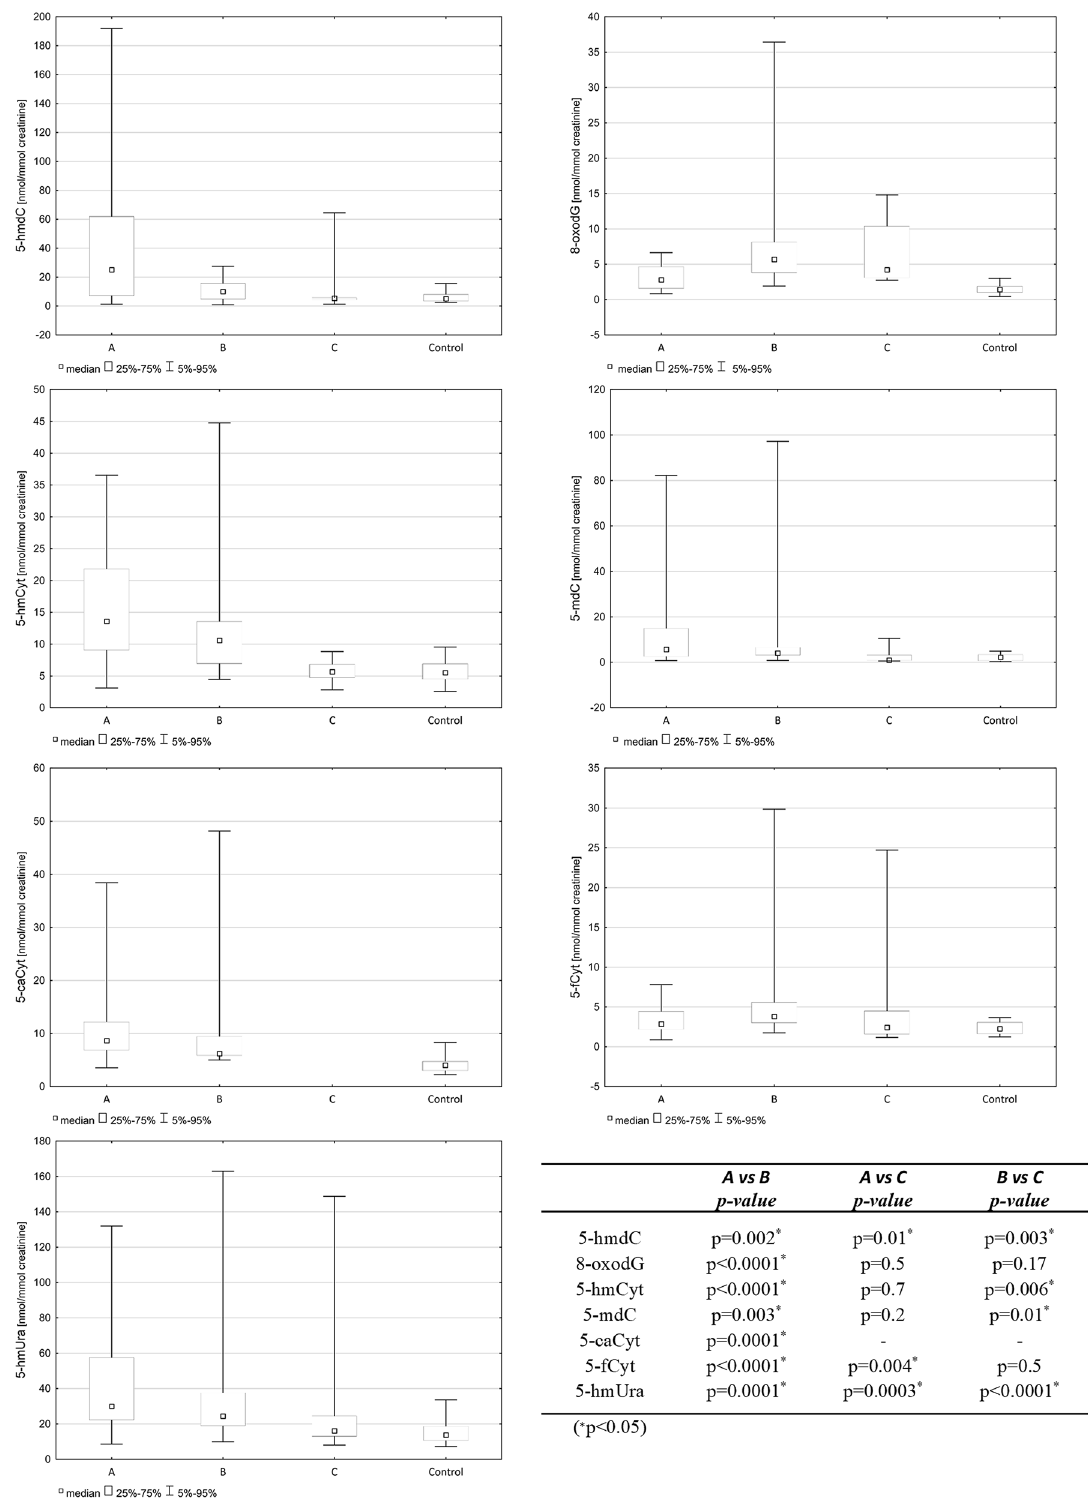
Figure 4. Urinary levels of DNA damage markers and active demethylation products of 5-methylcytosine in healthy controls and ALL patients before therapy (A), 33 days after treatment (B) and six months after treatment (C). The results are presented as median values